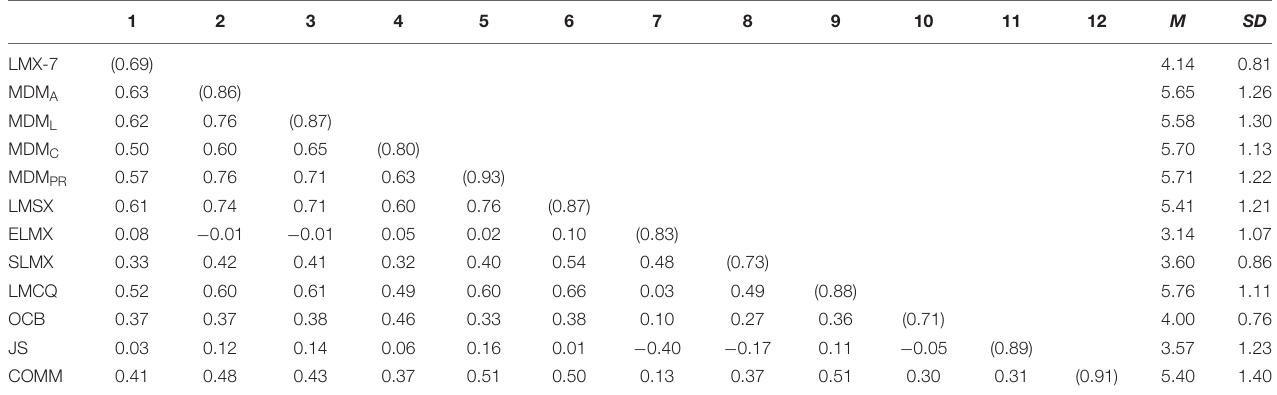
TABLE 8 | Correlations, alphas, means, and standard deviations (Study 3).